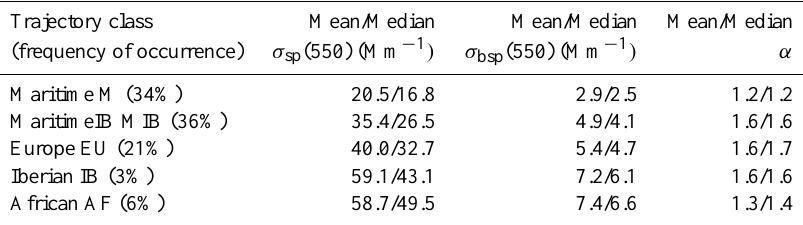
Fig. 7. Probability density for back trajectories at ´Evora ( a – e ) and average path (f) for each trajectory category. The frequency of occurrence for each trajectory category is also shown. Table 6. Average and median values of σ sp (550), σ bsp (550) and α for each trajectory type. The frequency of occurrence for each type is also